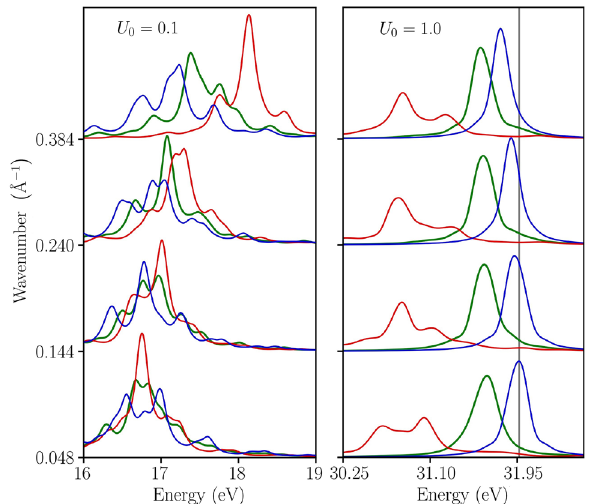
Figure 2. Novel modes in the EELF at weak and strong perturbation amplitudes. An optical mode emerges at a strong perturbation amplitude U 0 = 1.0 . The dependence of these modes on q and on the degeneracy parameter θ (solid blue denotes θ = 0.1 , solid green θ = 0.5 , and solid red θ = 1.0 ) is strong and depends on the imposed perturbation amplitude U 0 . The vertical grey line is a guide to the eye and helps to observe that at U 0 = 1.0 the dispersion shifts to lower frequencies with increasing wave vector q .